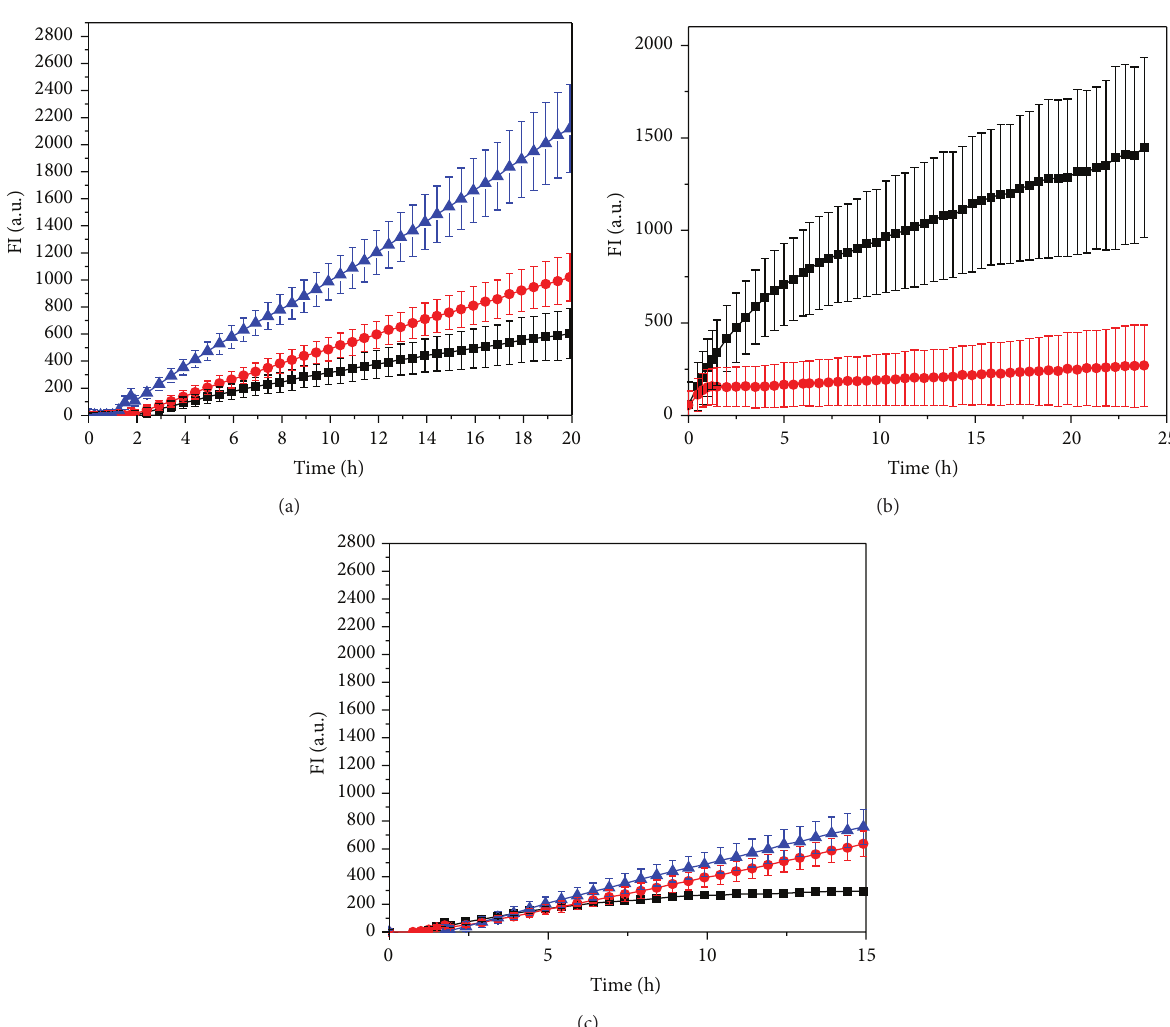
than in cells having the plain vector or in lysates